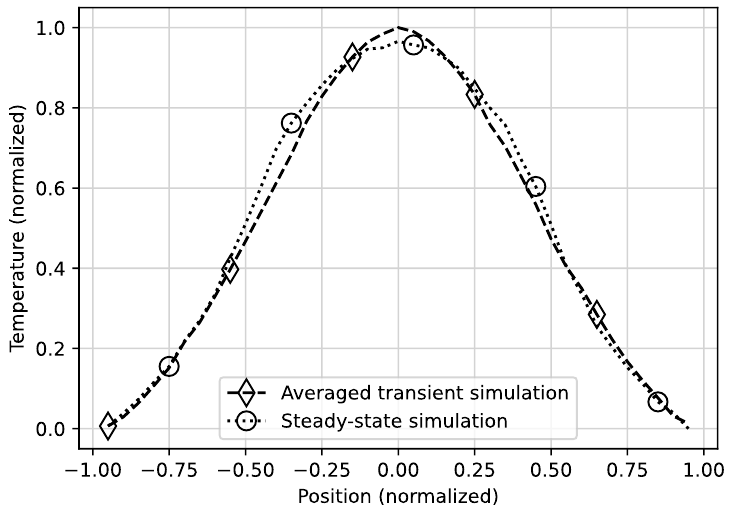
Figure 4. Results for the basic set of input variables. Shown is a comparison between the time-averaged temperature distribution of the transient simulation and the temperature distribution of the steady-state simulation. Values on the x- and y-axis have been normalized to their respective minimum and maximum values.